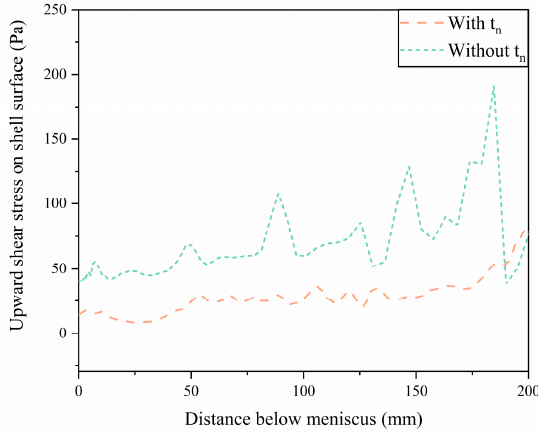
Figure 15. Comparison of the shear stress acting on the shell with and without 𝑡 (cid:3041) .